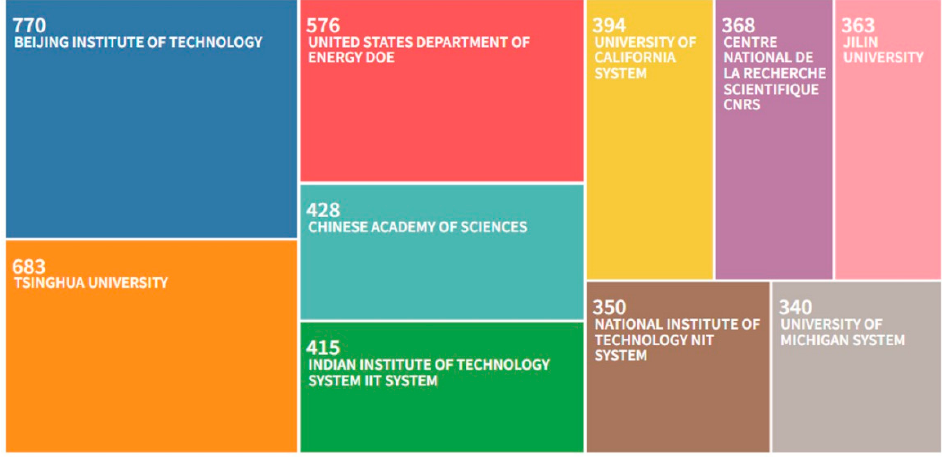
Figure 5. TreeMap of the top 10 institutions that published the most studies on electric vehicles.